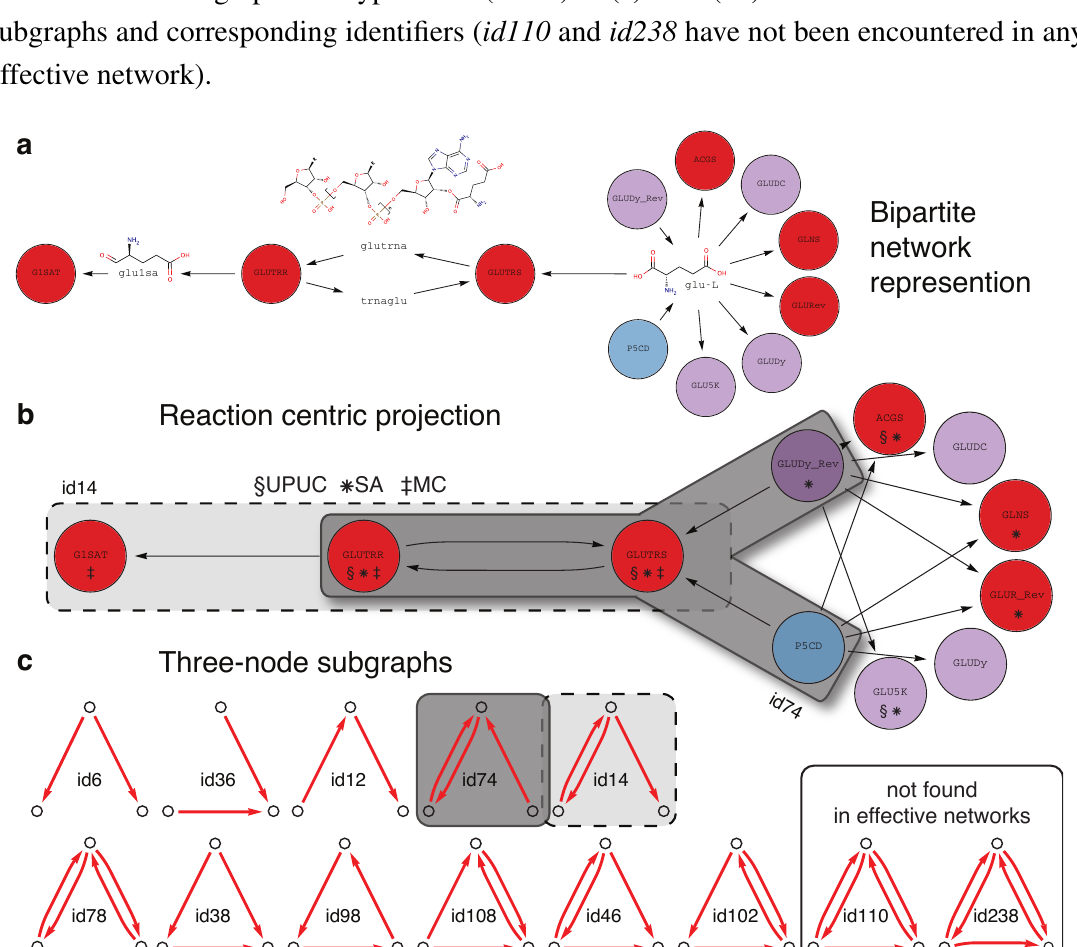
Figure 3. ( a ) Bipartite network representation of the two step conversion of L-glutamate ( glu-l ) into L-glutamate-1-semialdehyde ( glu1sa ) involving glutamyl-tRNA synthetase ( GLUTRS ; 6.1.1.17) and glutamyl-tRNA reductase ( GLUTRR ; 1.2.1.-).